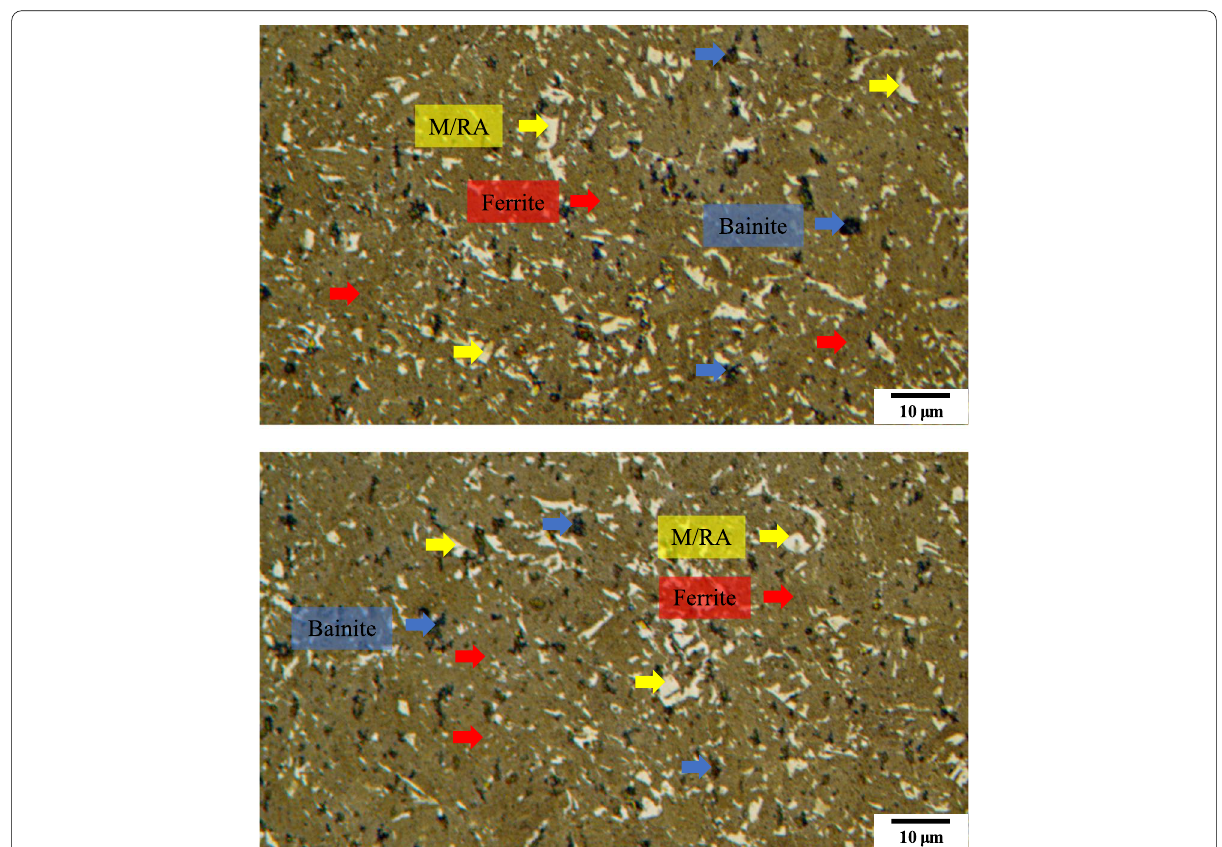
Fig. 5 Optical micrographs subjected to Final etching conditions of LePera etching of 4Nb specimen. It can distinguish clearly the M/RA and matrix phase. Also, Bainite phases are observed in black